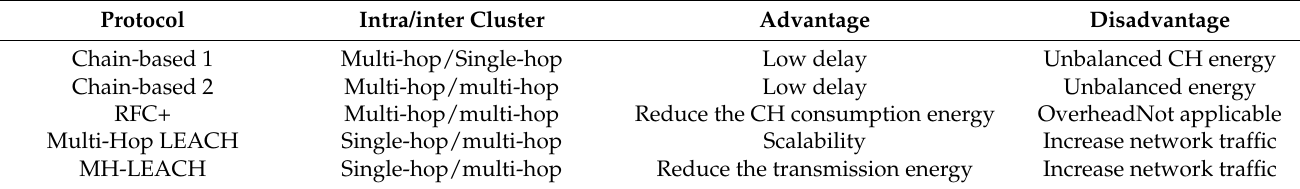
Table 3. Comparison of Hierarchical Multi-Hop Routing